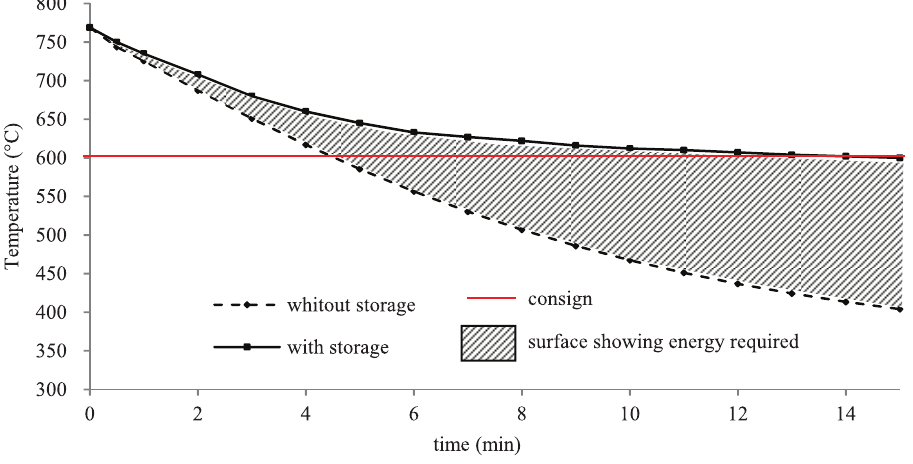
Fig. 2: Target evolution of the receiver outlet air temperature in absence of solar flux (Drawn from Grange thesis